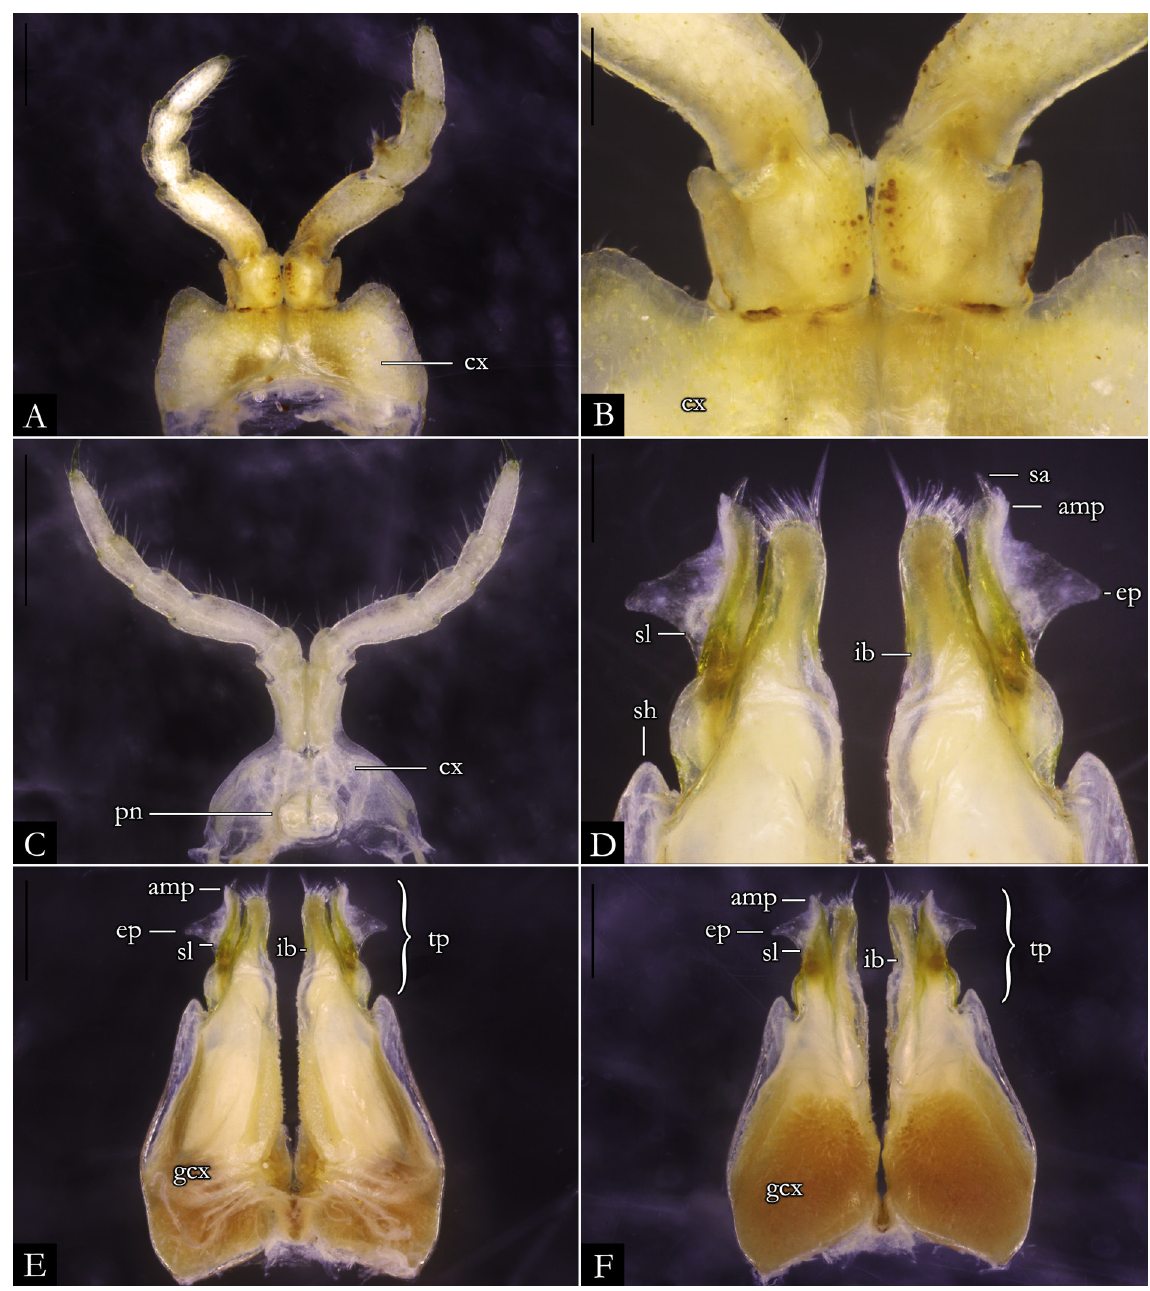
Fig. 49. Pseudonannolene anapophysis Fontanetti, 1996, ♂ (IBSP 5209). A . First leg-pair. B . Detail of prefemur. C . Second leg-pair. D . Detail of telopodites, in anal view. E . Gonopods, in anal view. F . Gonopods, in oral view. Abbreviations: see Material and methods. Scale bars: A, E–F = 0.5 mm; B, D = 0.2 mm; C = 1